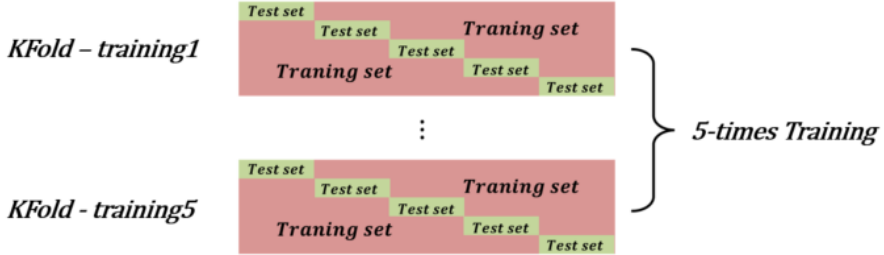
Figure 10. Dataset division into training set and test set using five-fold